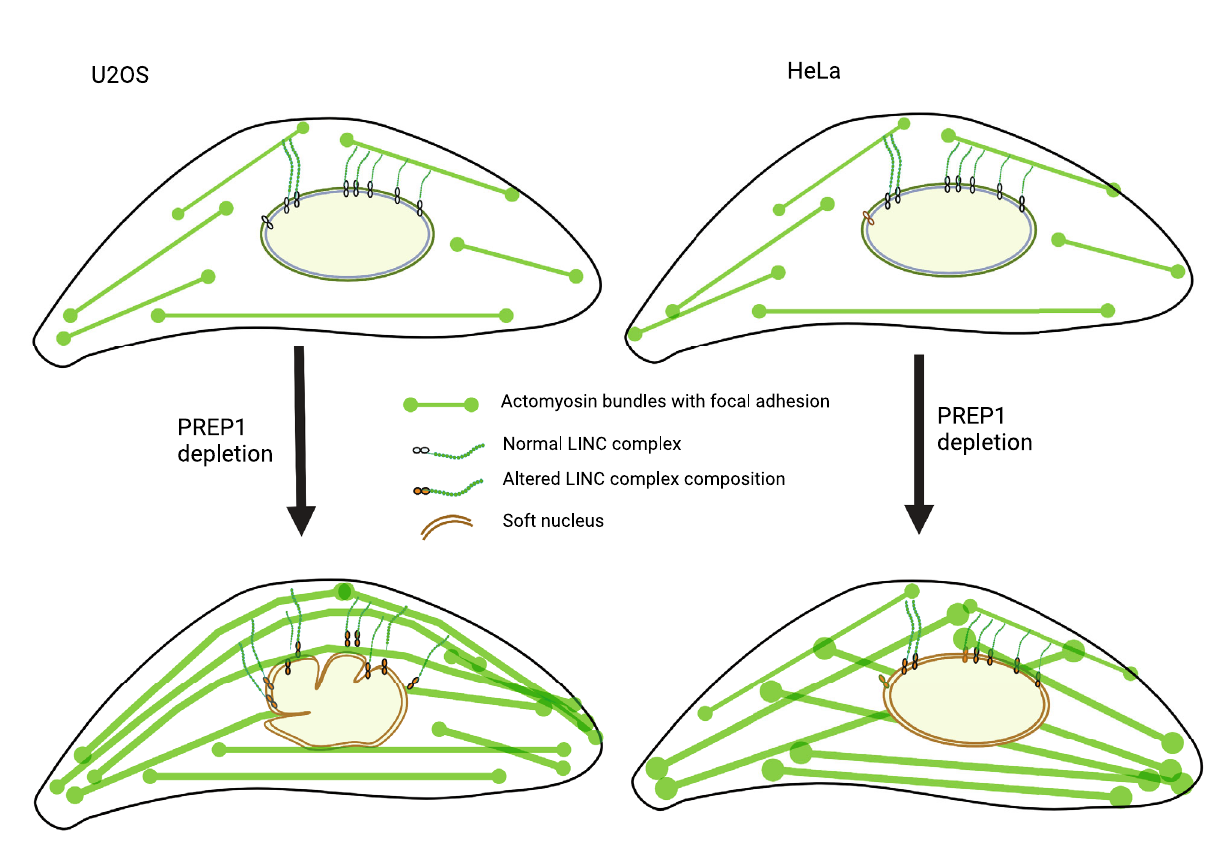
Fig. 6 Schematic representation of the effects of PREP1 depletion in U2OS vs HeLa cells. Schematic view (created with BioRender.com) showing the differential response of U2OS and HeLa cells to PREP1